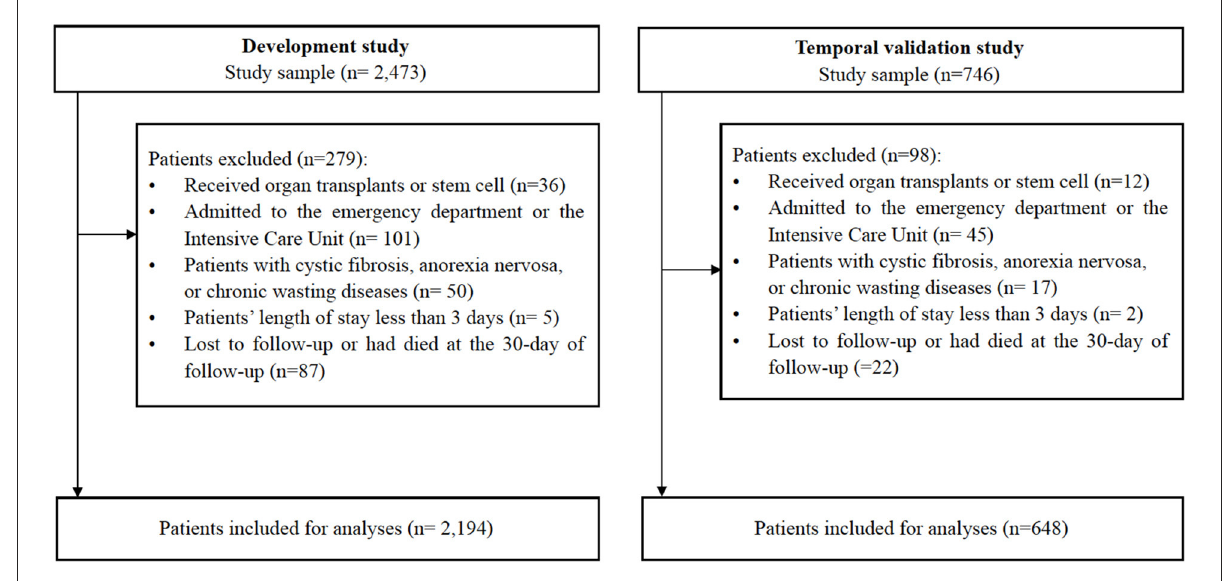
FIGURE1 Inclusion/exclusion cascade of patients in the dataset ( n = 2,842).